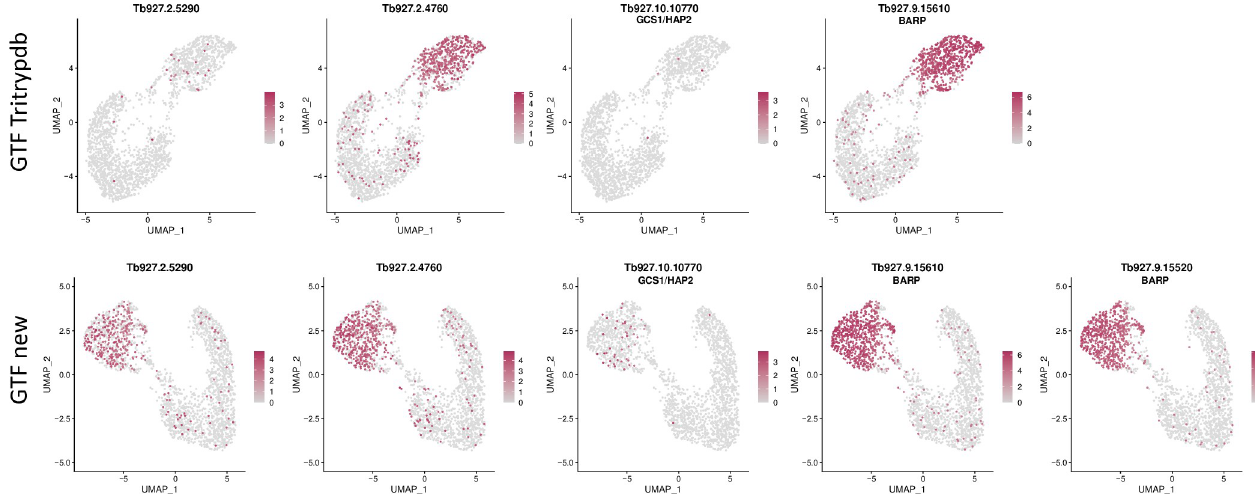
Fig 6. UMAP coloured by transcript counts for selected genes using GTF files from TriTrypDB (upper panel) and this study (GTF new, lower panel). The scRNA-seq dataset was obtained from Vigneron et al. [41]. The colour scale shows raw transcript counts per cell. The epimastigote cluster is identified by the presence of BARP transcripts. Different BARP isoforms are expressed to different extents. Tb927.9.15620 was not identified with the GTF file from TritrypDB.